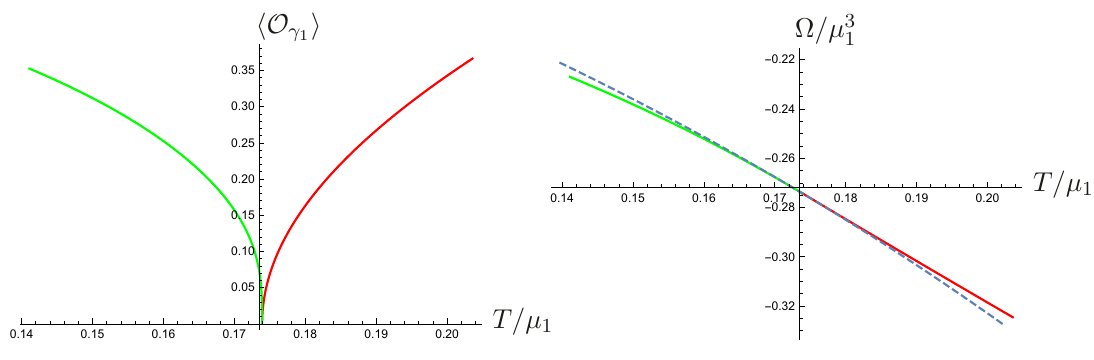
Figure 1 . Left panel: expectation value and model DG-B (red curve). Right panel: grand potential densities Ω = (green curve) , (red curve) , (dashed blue curve) {